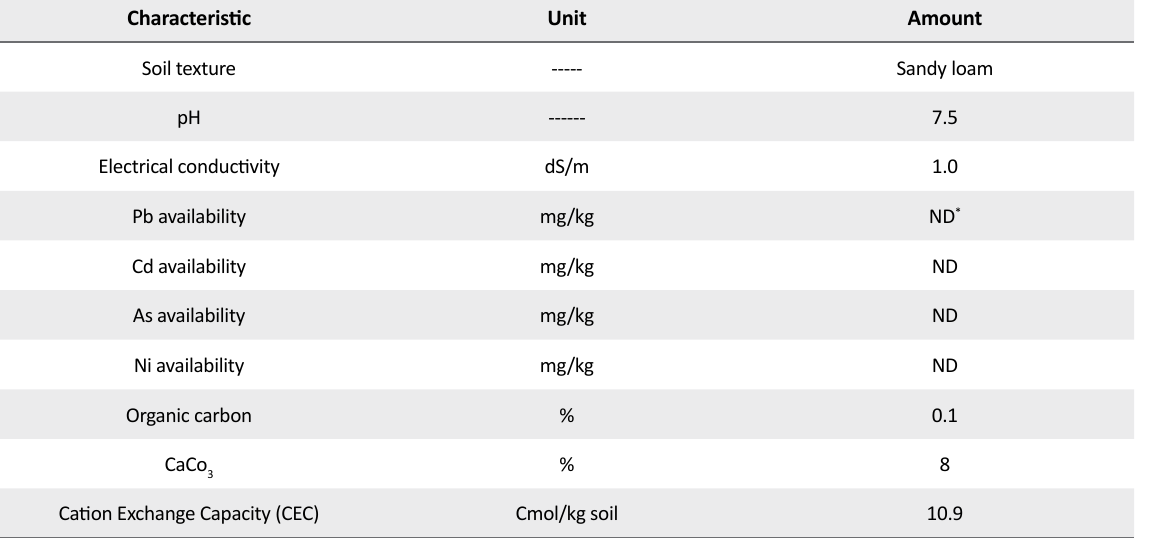
Table 1. Physicochemical properties of the studied soil